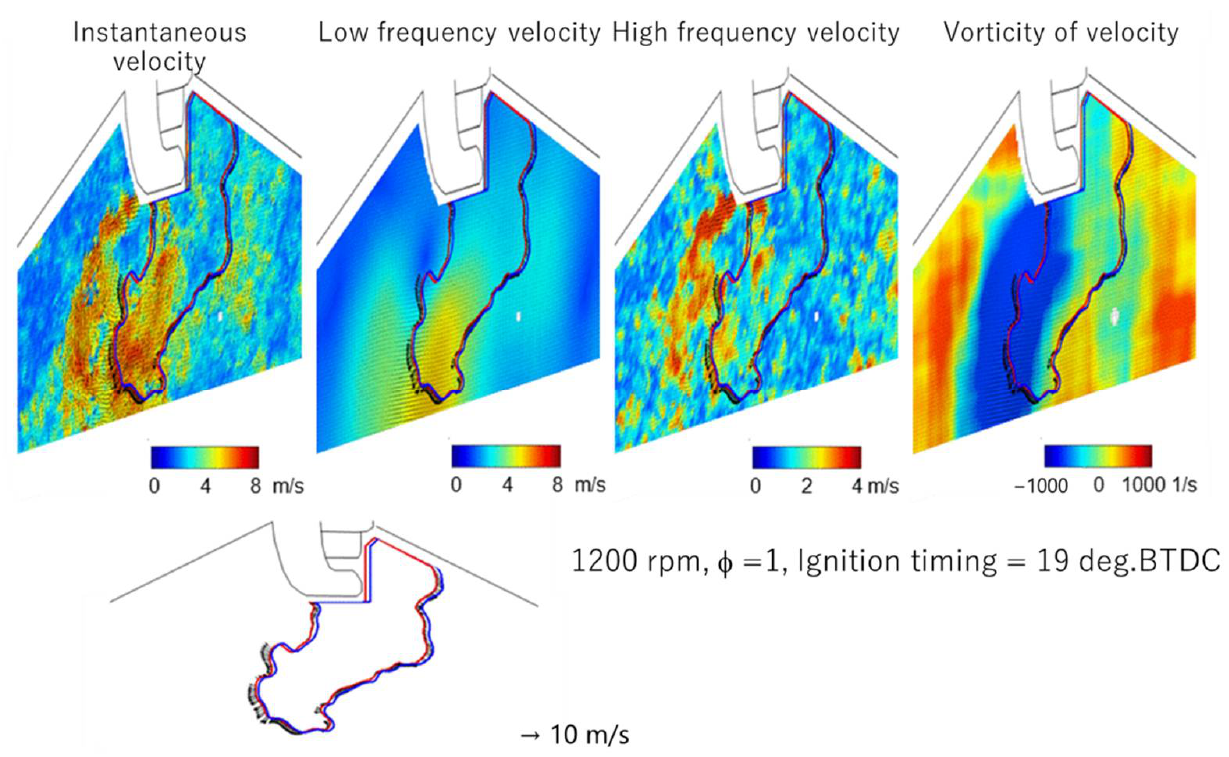
Figure 10. Interaction of flame front and bulk flow with turbulence component as well as vorticity of different cycles.